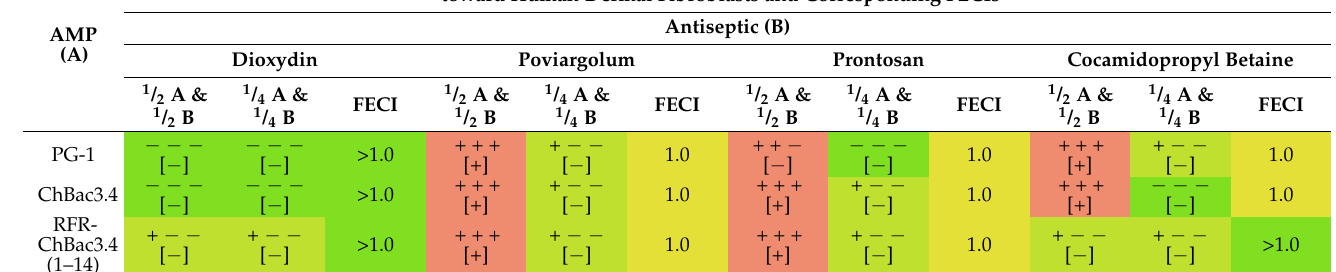
Table 6. Toxicity of combinations of AMPs with antiseptics and surfactants toward human dermal